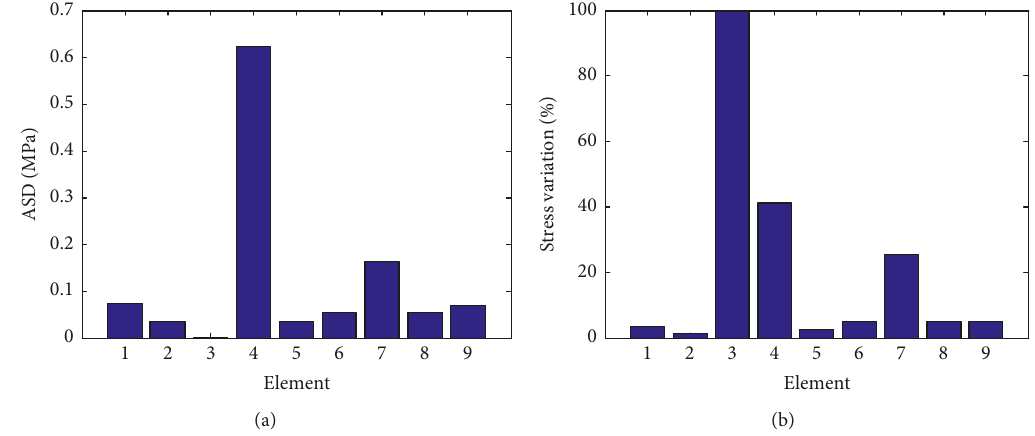
Figure 7: Multiple damages at elements ④ and ⑦ using 5% noise-contaminated measurements and the disassembling-based approach of (a) ASD and (b) stress variation rate.